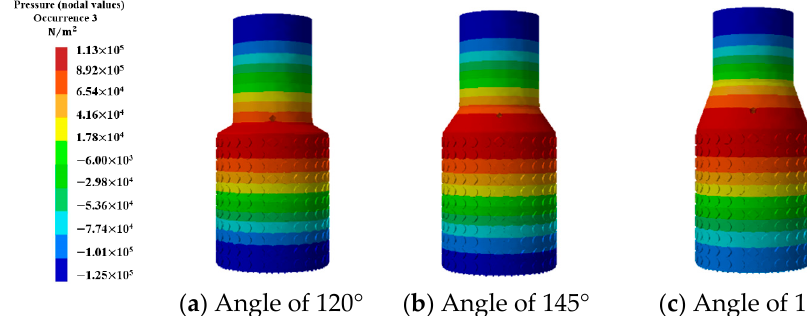
Figure 10. Third-order acoustic cavity modality.